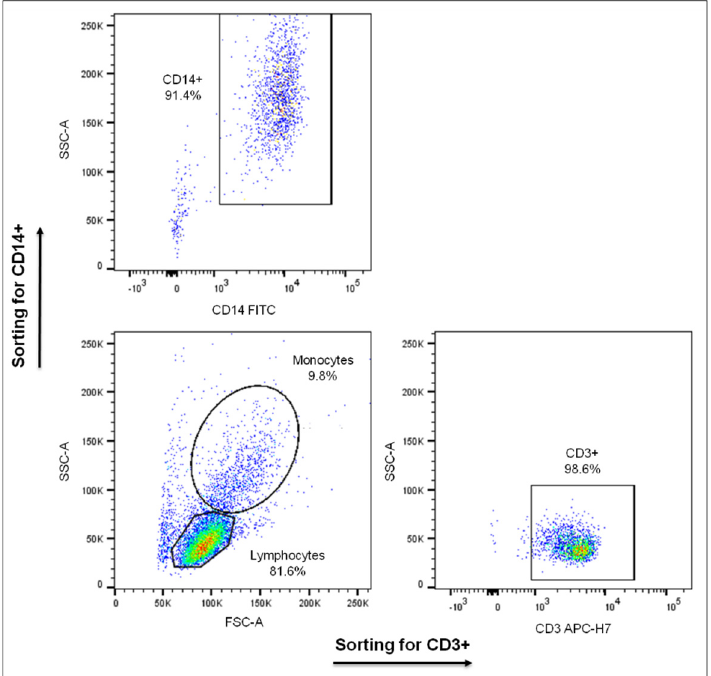
Figure 8. Sorting strategy for the isolation of CD3+ T cells and CD14+ monocytes from PBMCs cultured as indicated in the text. Characteristic dot plots showing the purity, after cell sorting with FACSAria. Table 2. PCR primer pairs used for the determination of cytokine gene expression. Gene Set of Primers (5 (cid:48) → 3 (cid:48)